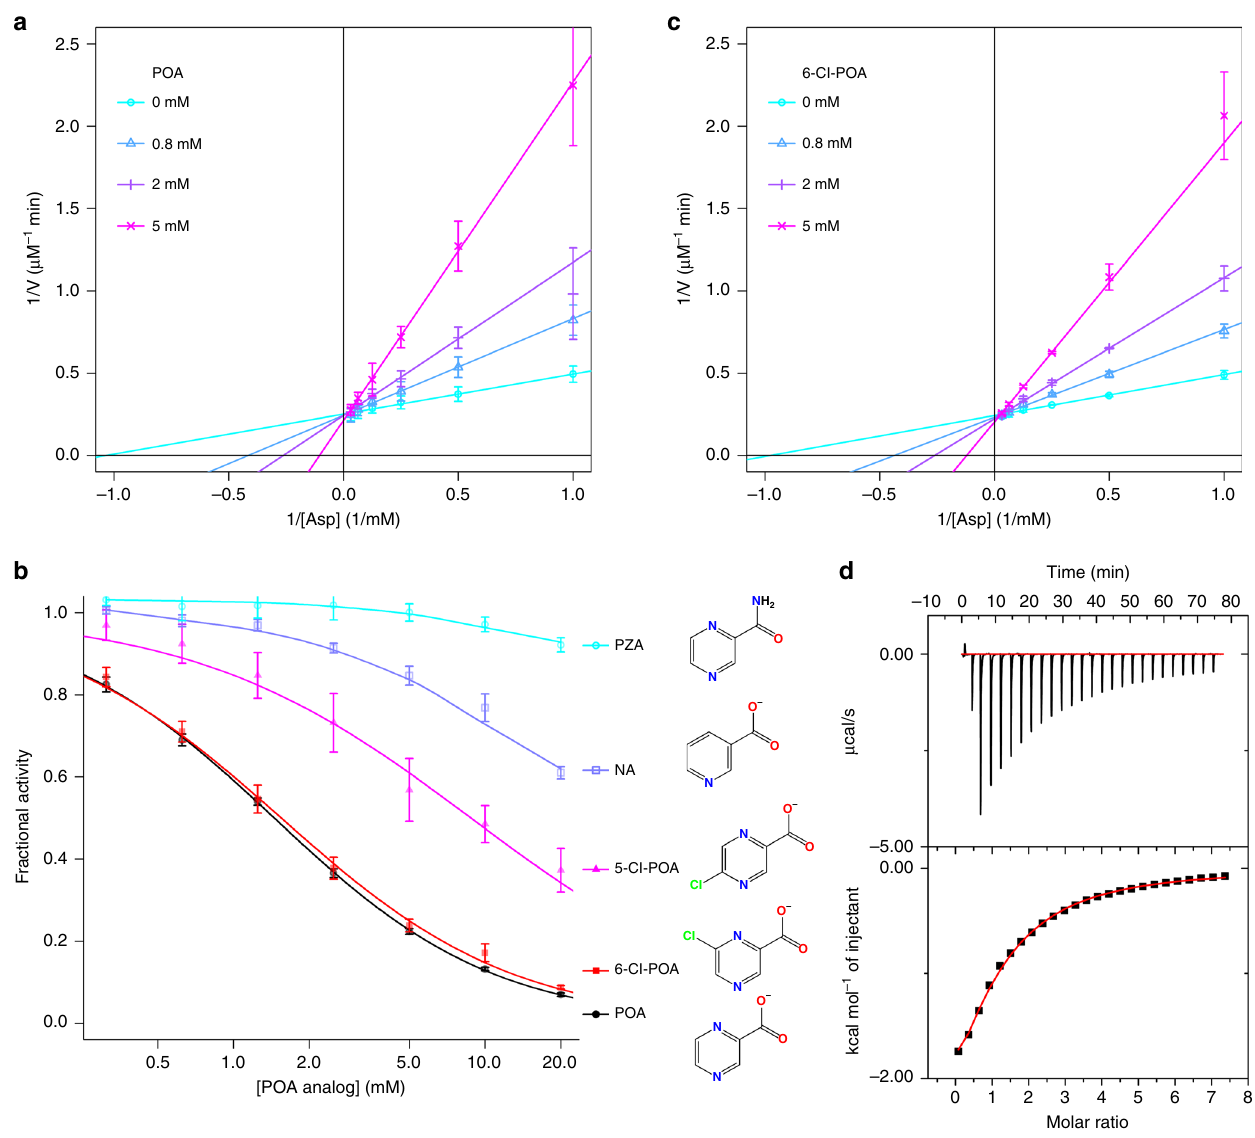
Fig. 1 Biochemical characterization of the interaction between Mtb PanD and POA. a POA showed competitive inhibition of Mtb PanD. Lineweaver – Burk plots of Mtb PanD activity in the presence of various concentrations of POA prepared in triplicate. The data were fi tted with a competitive inhibition model, yielding K i = 0.78 (0.05) mM, K M = 1.08 (0.06) mM, and k cat = 0.330 (0.006) s − 1 . b Inhibition of PanD activity with POA analogs. Dose – response curves were measured using the described PanD assay with pyrazinamide (PZA), nicotinic acid (NA), 5-Cl-POA, 6-Cl-POA, and POA. There were six replicates. c 6-Cl-POA inhibits Mtb PanD comparatively to POA. The plot was indicative of a competitive model of inhibition with K i = 1.00 (0.04) mM, K M = 1.12 (0.04 mM), and k cat = 0.350 (0.003) s − 1 . d Isotherm calorimetry of Mtb PanD with POA. The top panel shows the heat released per injection of inhibitor, as µ cal s − 1 ; while the bottom panel shows the change in enthalpy (kcal mole − 1 ) as a function of the molar ratio of POA to PanD. Titrations were performed at 20 ° C using 100 mM Tris buffer (pH 7.5) for both the protein solution and POA titrant. The data were fi tted with a single-site binding model. From fi ve separate experiments, it was calculated that K d = 0.71 (0.03) mM, Δ H = − 4200 (200) cal mol − 1 , Δ S = 0.1 (0.7) cal mol − 1 deg − 1 . Error bars were de fi ned as standard deviations. Source data are provided as a Source Data fi